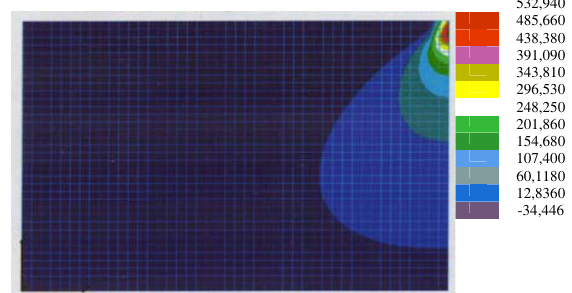
Fig 5 . Shear stress xy τ distribution in the sample if analysed by oedometer with a fixed ring and stiff stamp (linear model)